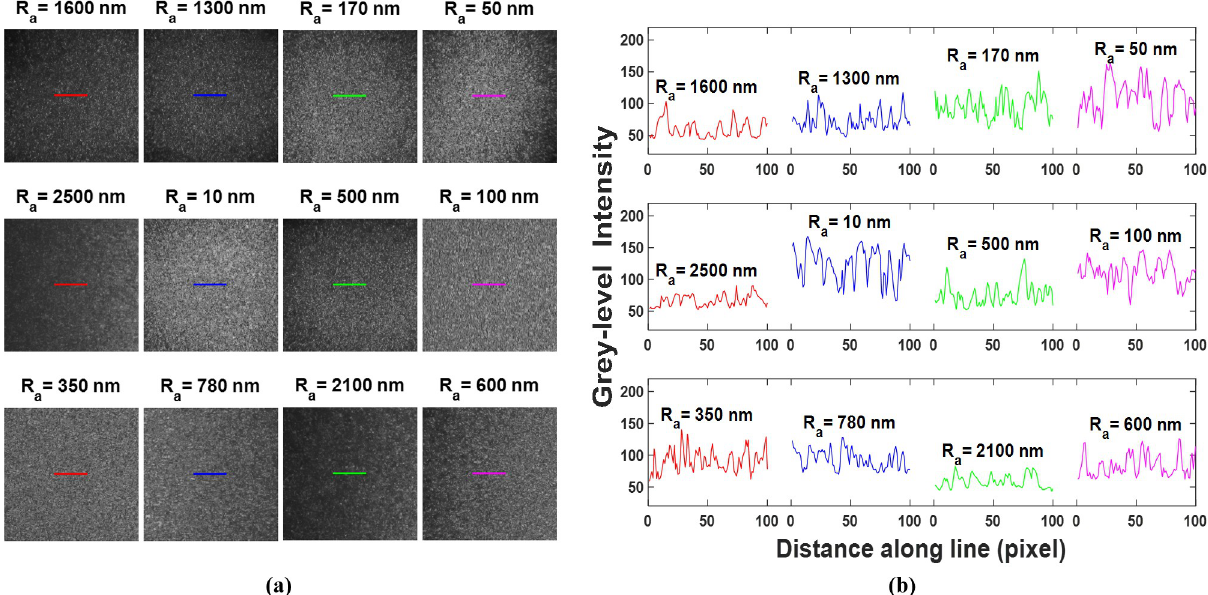
Fig 4. (a) Eight-bit gray-level display of twelve biospeckle images, with a dimension of 400 × 400 pixels, collected from twelve degenerated cross-section areas of a bovine articular cartilage specimen, and (b) gray-level intensity distribution along the colored lines passing over the biospeckle images presented in